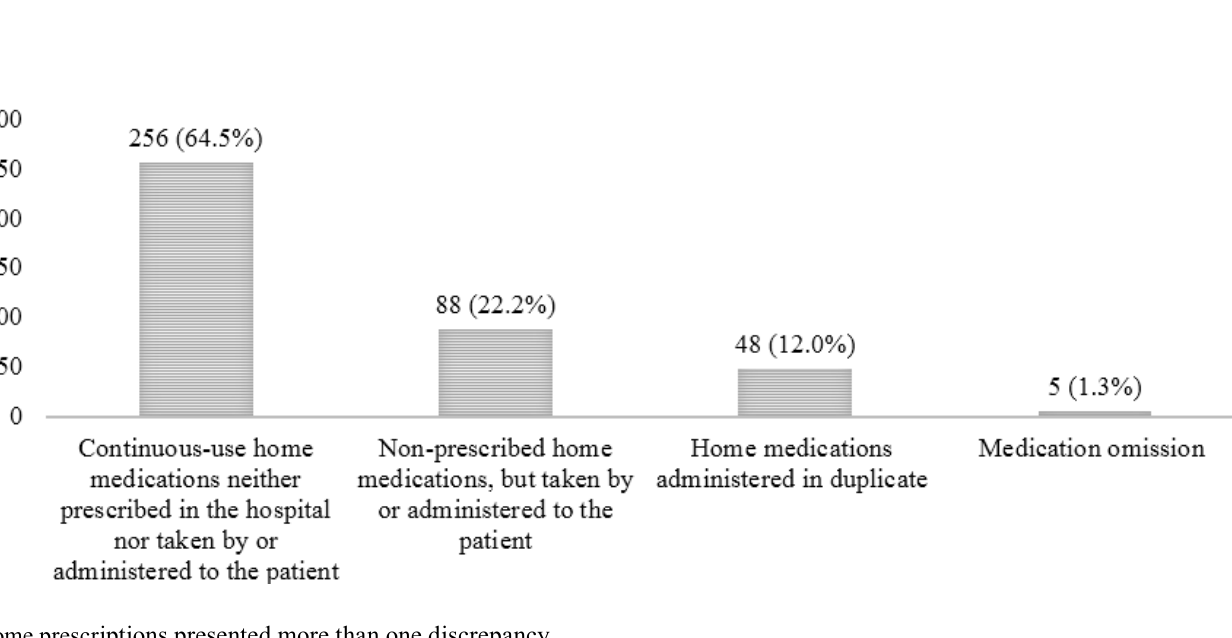
FIGURE I – Distribution of types of drug discrepancy found among the study participants during their hospital stay,